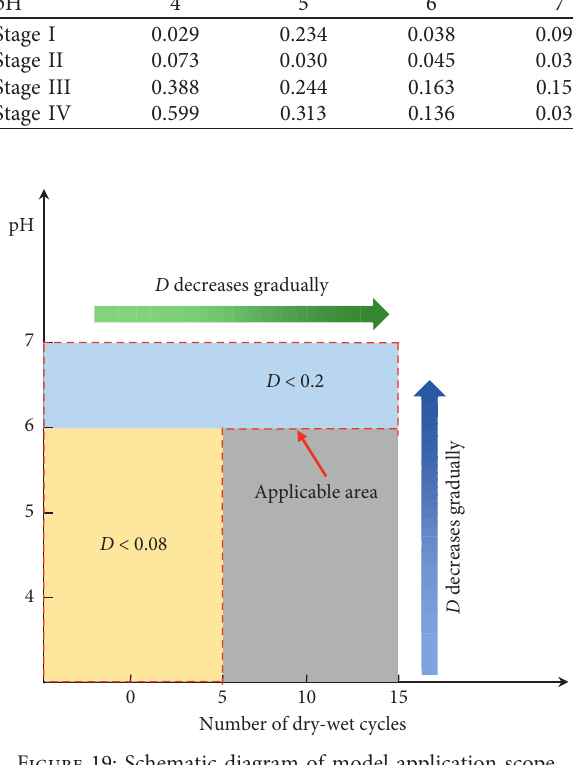
Figure 19: Schematic diagram of model application